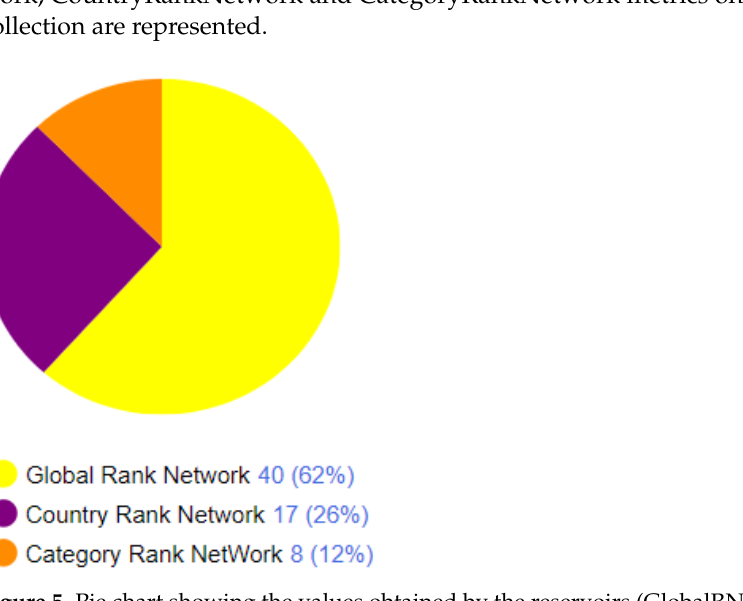
Figure 5. Pie chart showing the values obtained by the reservoirs (GlobalRNetwork CountryRNetwork and CategoryRNetwork) on the sixtieth day of measurement.